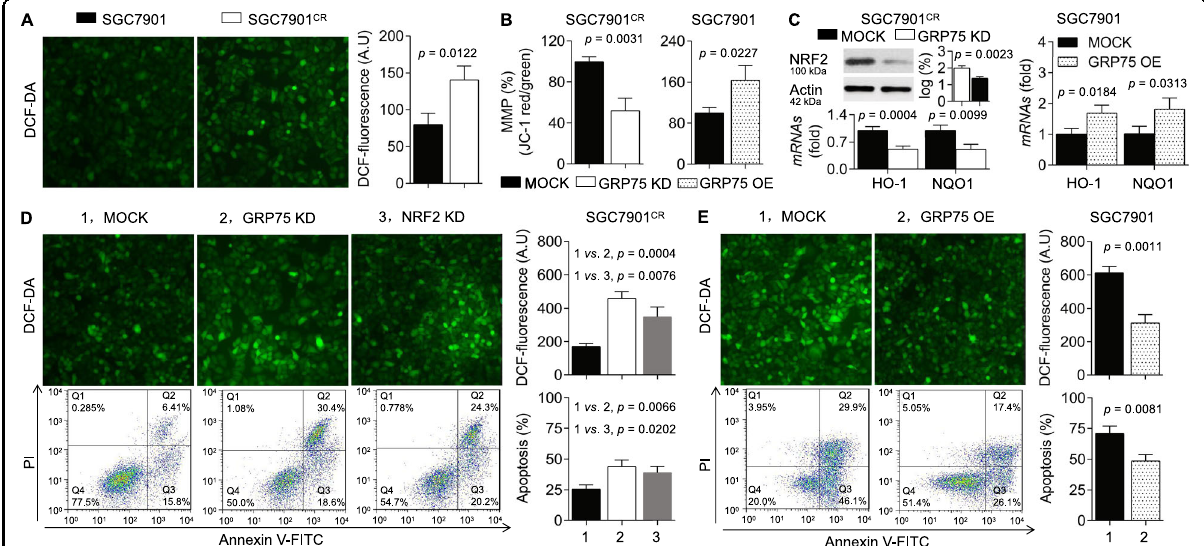
Fig. 3 Effects of GRP75 on anti-oxidation and anti-apoptosis. A The intracellular ROS levels of SGC7901 CR or SGC7901 cells were determined in triplicate. B – E SGC7901 CR cells were transfected by scrambled or GRP75 siRNA, while SGC7901 cells were transfected by scrambled or GRP75 plasmids. After then, they were treated with 5 or 2.5 μ M of cisplatin for 24 h. B MMP of GC cells was measured and calculated. C Western blot analysis of the levels of NRF2; and qPCR analysis in triplicate of the expressions of HO-1 and NQO-1. D and E The intracellular ROS levels and apoptosis rates (early apoptosis plus late apoptosis) were determined in